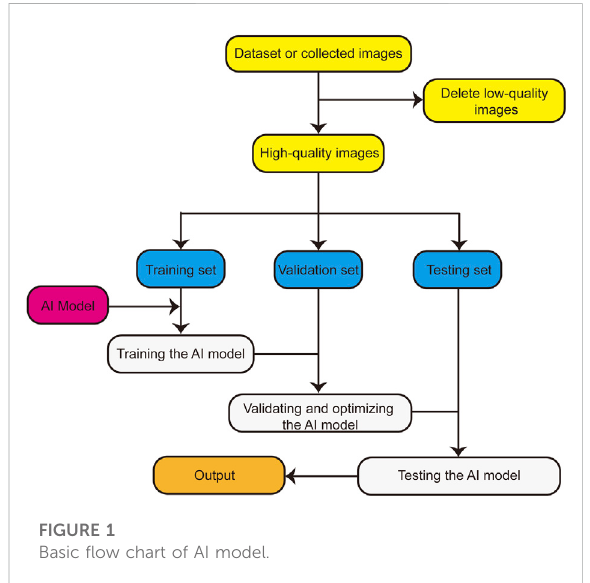
FIGURE 1 Basic fl ow chart of AI model.